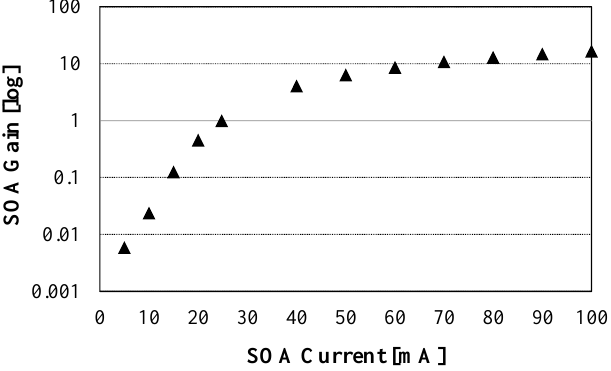
Figure 6. SOA Gain vs. Drive Current.